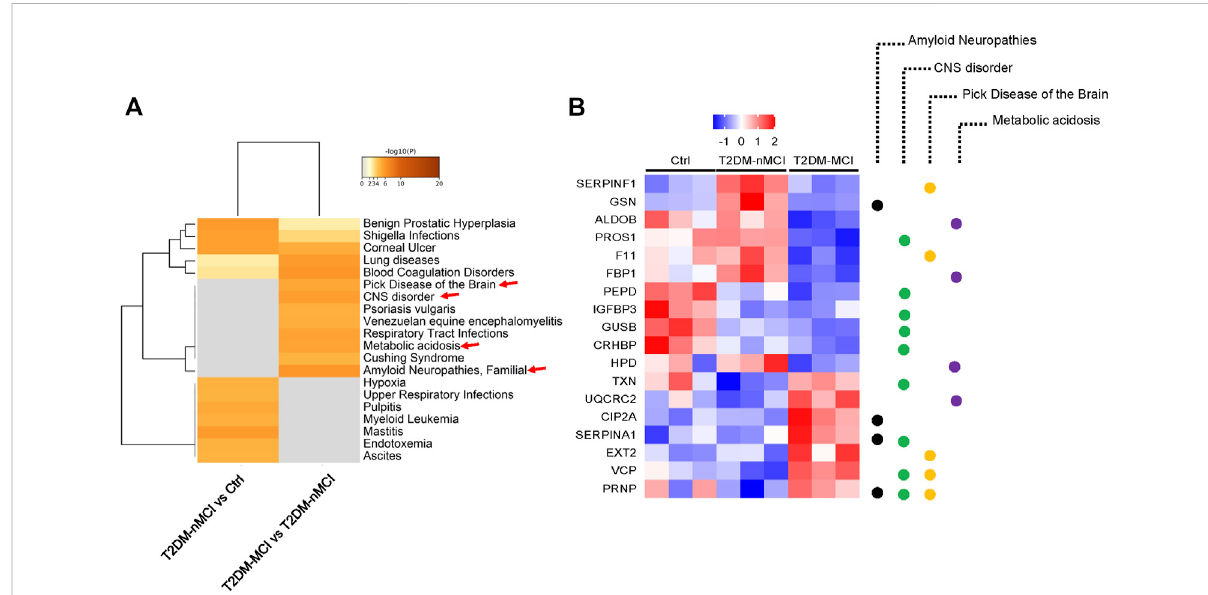
FIGURE 2 Integrating information on human disease-associated DEPs analyzed using Metascape. (A) Top GO terms of the gene – disease network (DisGeNET) with -log10 ( p-value < 0.01). (B) Relative expression abundance of amyloid neuropathies, CNS disorder, Pick ’ s disease, and metabolic acidosis ( p < 0.05, increased proteins: red; decreased proteins: